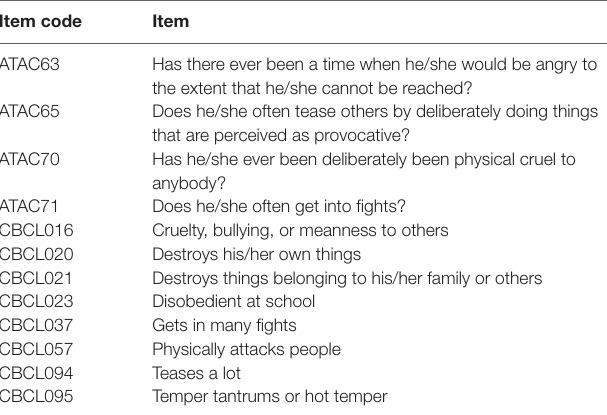
TABle 5 | Overt/physical aggression items in Aggression in Children: Unraveling gene-environment interplay to inform Treatment and InterventiON strategies. Item code